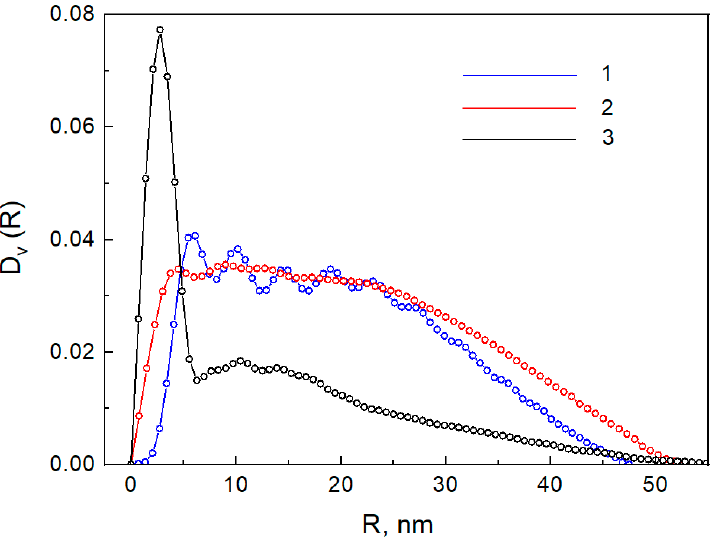
Figure 8. Volume functions of pore distribution in samples NC1_10 (1), NC1_5 (2), NC2 (3).